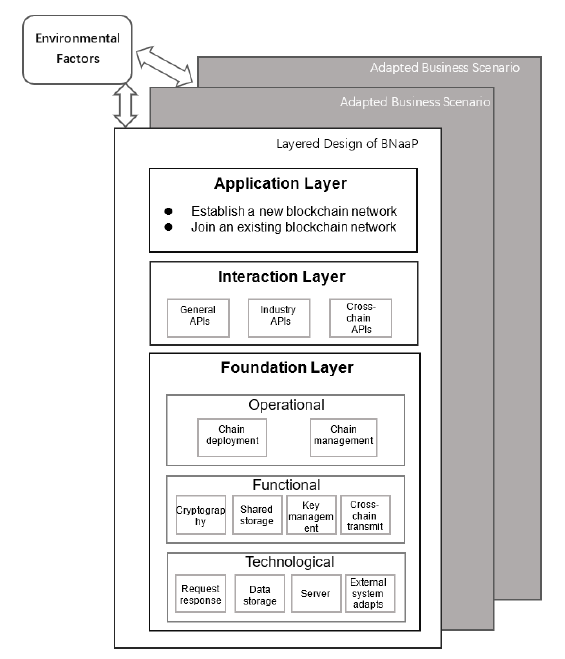
Figure1: The Adapted Layered Architecture of